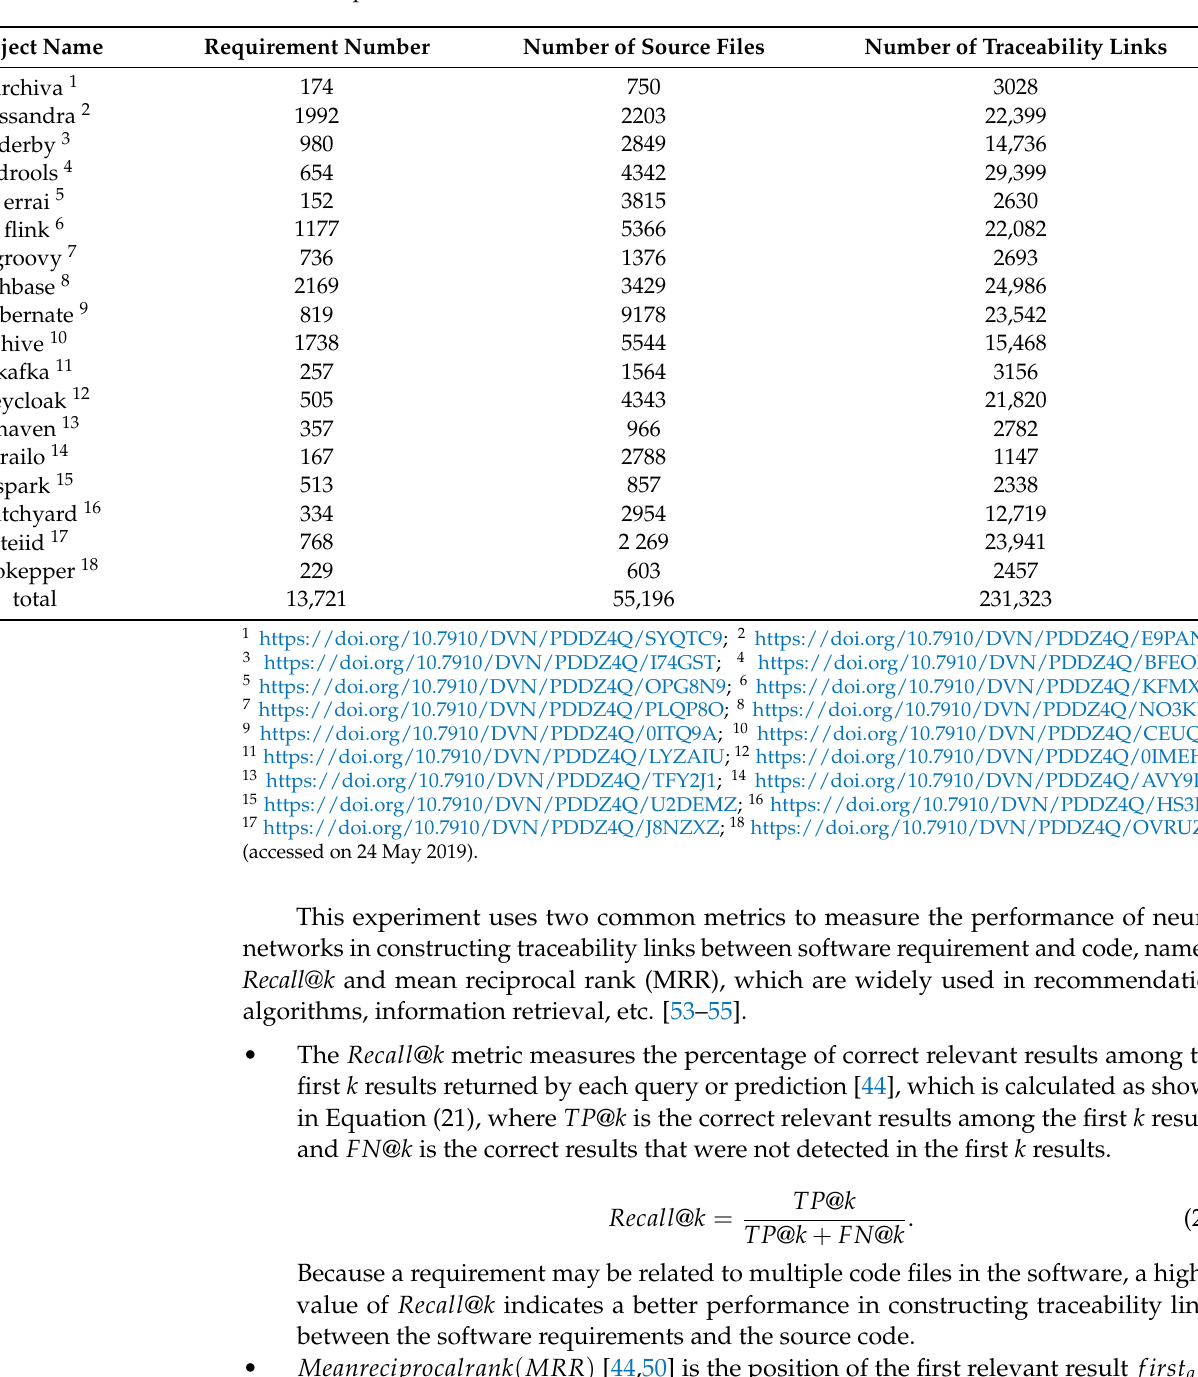
Table 2. Experimental